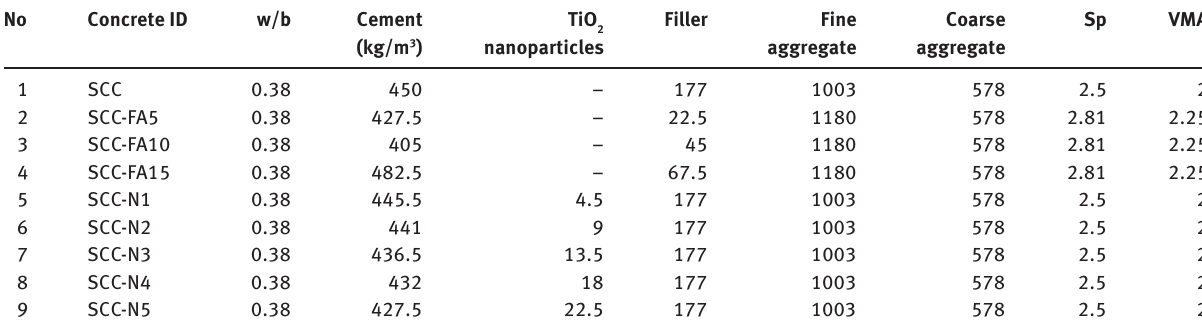
Table 6 Mix proportions of the concrete